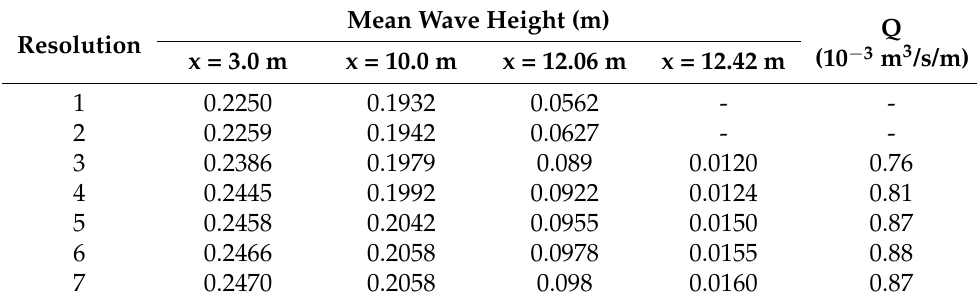
Table 11. Overtopping case: mean wave height at gauges located at x = 3.0, 10.0, 12.06 and 12.42 m and the mean wave overtopping discharge obtained in